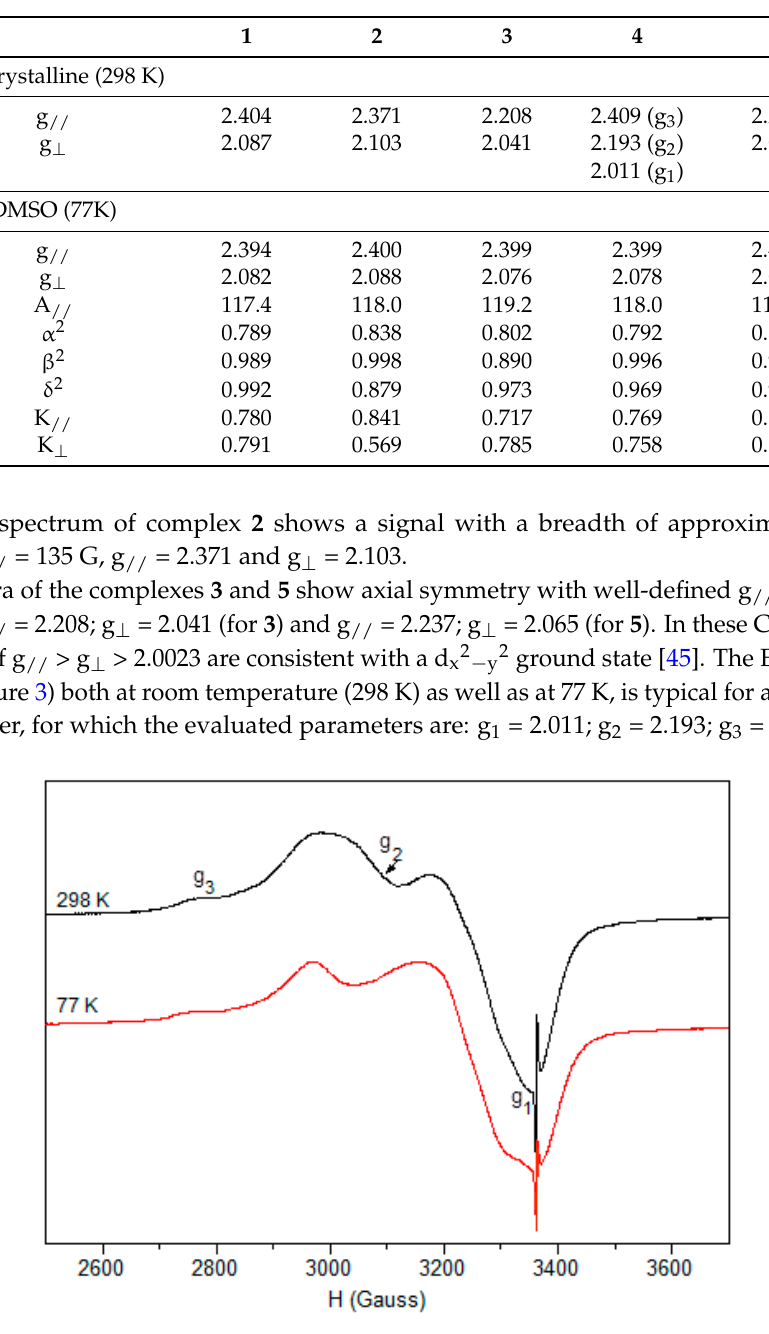
Table 2. EPR spectral parameters of the Cu(II) complexes 1 – 5 .